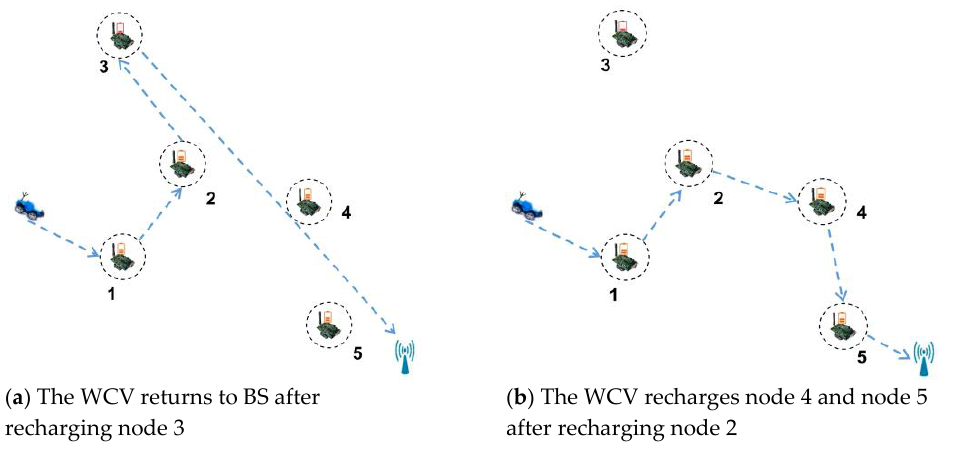
Figure 16. Greedy mobile scheme based on maximum recharging benefit.